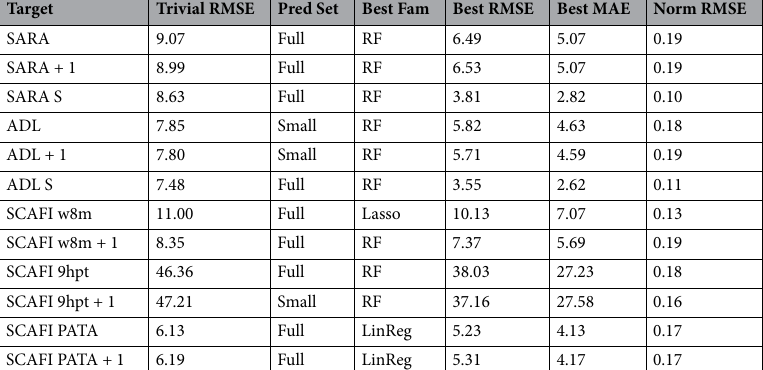
Table 2. Predictions of continuous data. The table shows the best performing models for each continuous target. Targets marked with + 1 are the results at the next visit only, while targets marked with S indicate modelling with allowing subjects to be present in training and test set at the same time. The best RMSE is the overall best result of all models, the best MAE is the MAE achieved from that model, thus not necessarily the overall best MAE reached. The trivial predictor for continuous targets was predicting the mean for all data points. For normalising RMSE, values were divided by the range of data. RMSE root mean squared error; Pred Set predictor set; Best Fam model family reaching the best result; MAE mean absolute error; Norm Normalised; RF random forest; LinReg inear regression; w8m 8 m walk test; 9hpt nine hole peg test.